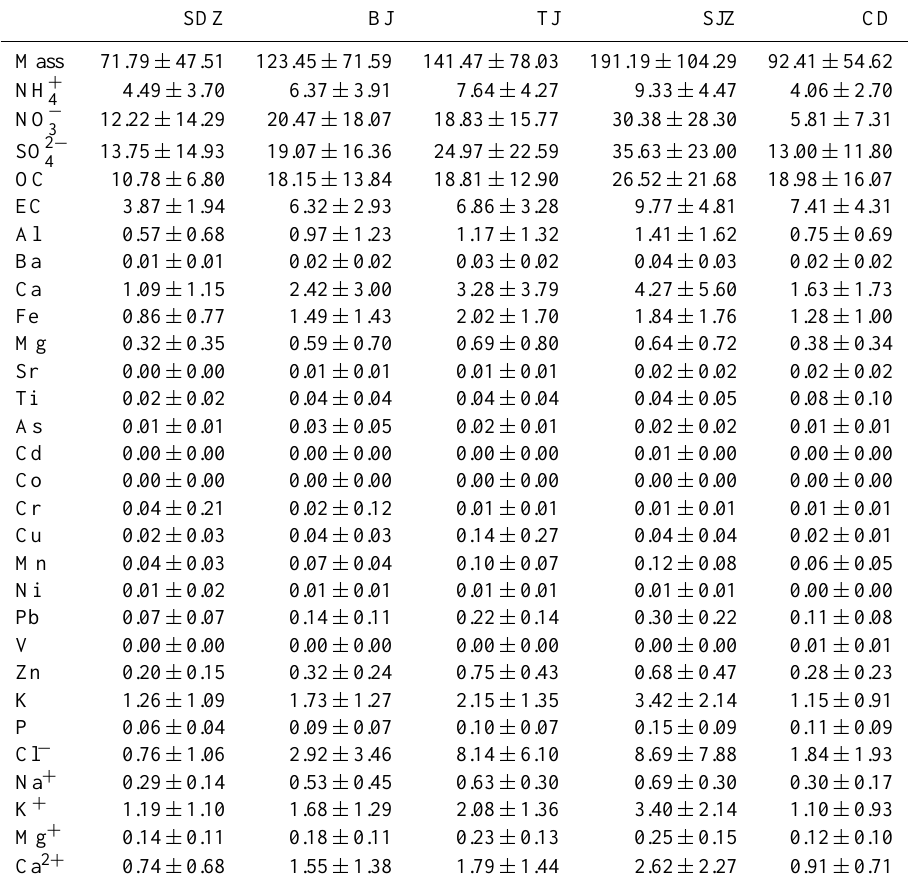
Table 2. Annual averages concentrations of PM 2 . 5 species at each site (µgm − 3 ) .